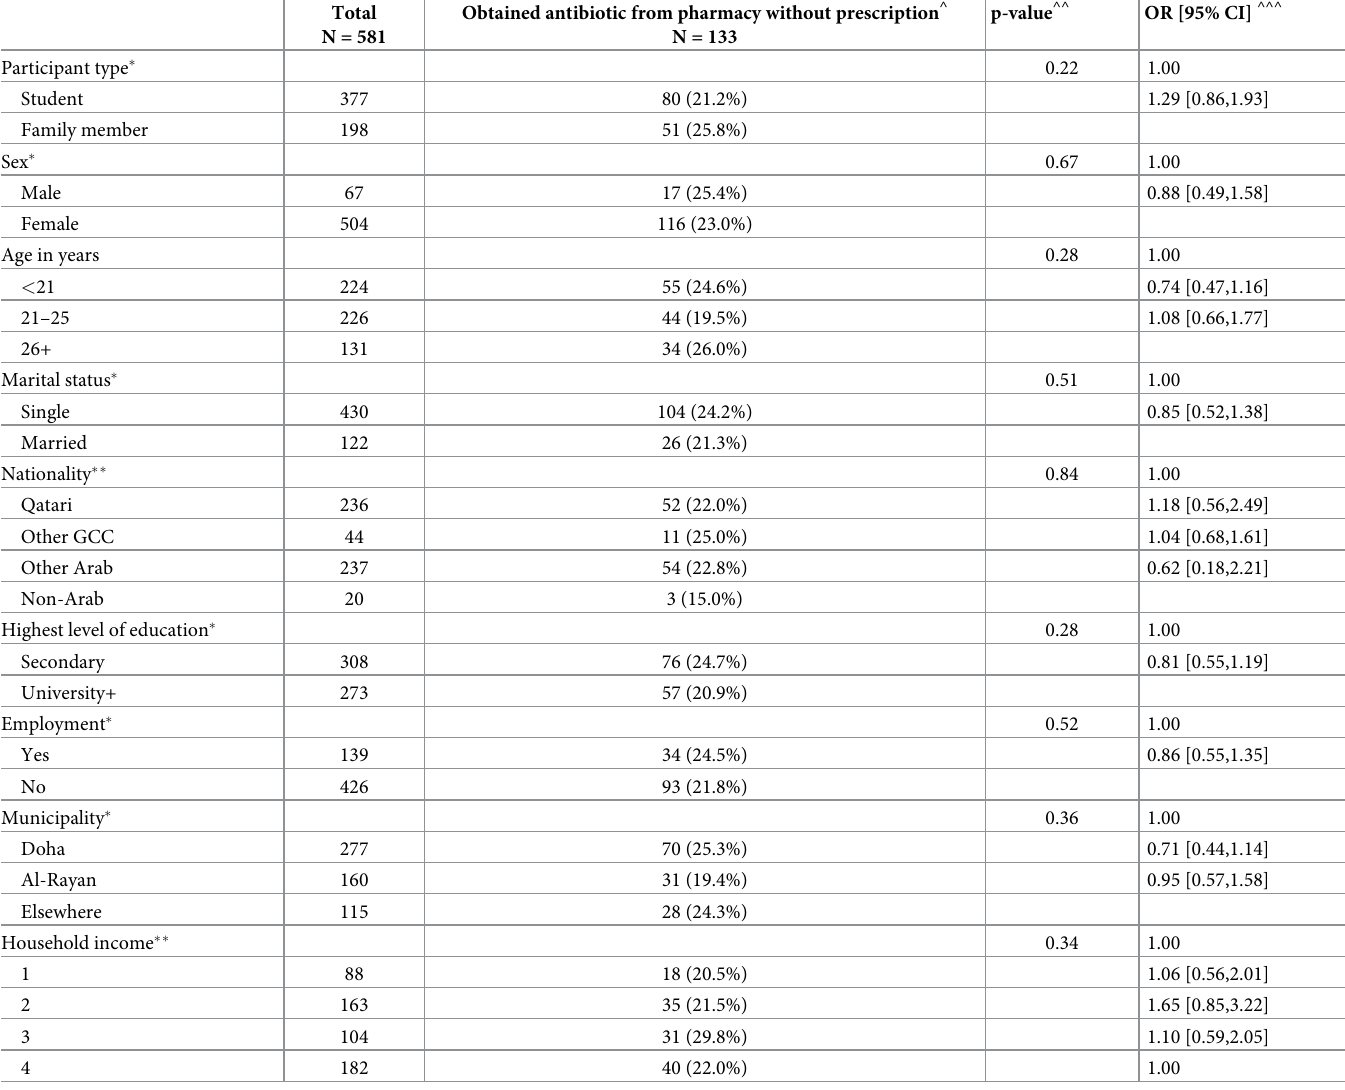
Table 5. Association between respondents’ characteristics and obtaining antibiotics from pharmacies without